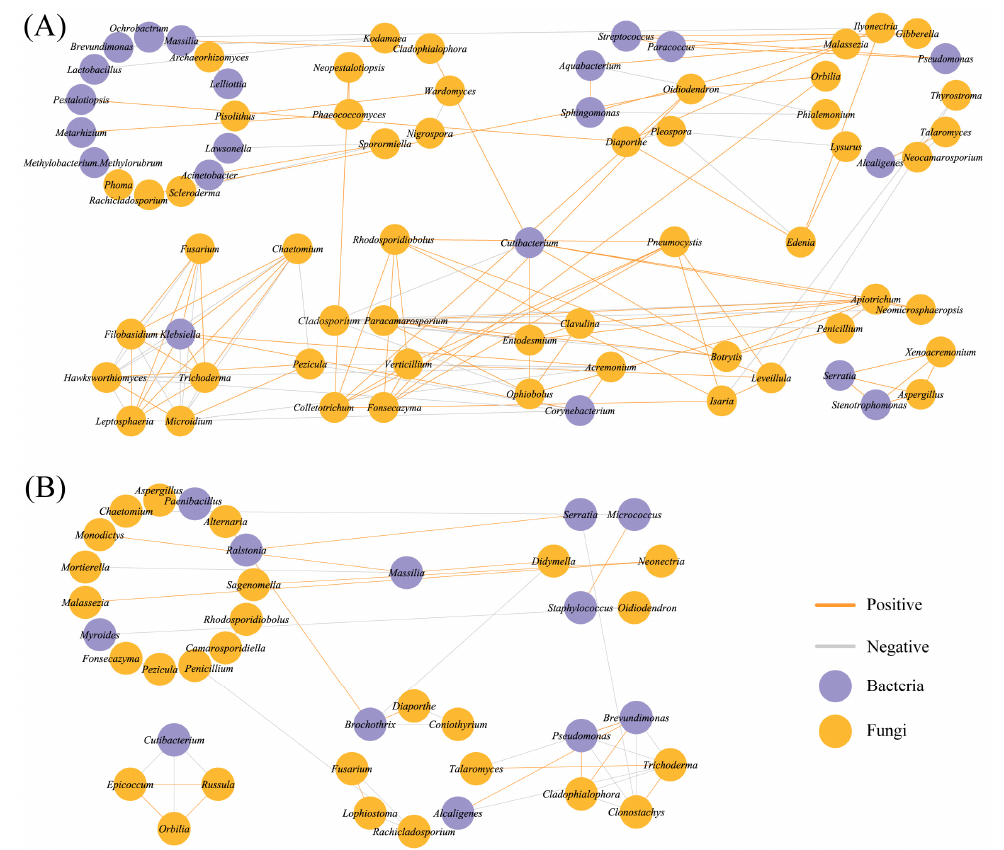
Figure 6. Correlation network of endophytic bacteria and fungi in young ( A ) and mature ( B ) branches of Nitraria Tangutorum . The orange lines represent positive links, the gray lines represent negative links, the purple circles represent bacteria, and the yellow circles represent fungi. Table 1. Network topological features of young and mature branches of Nitraria tangutorum .